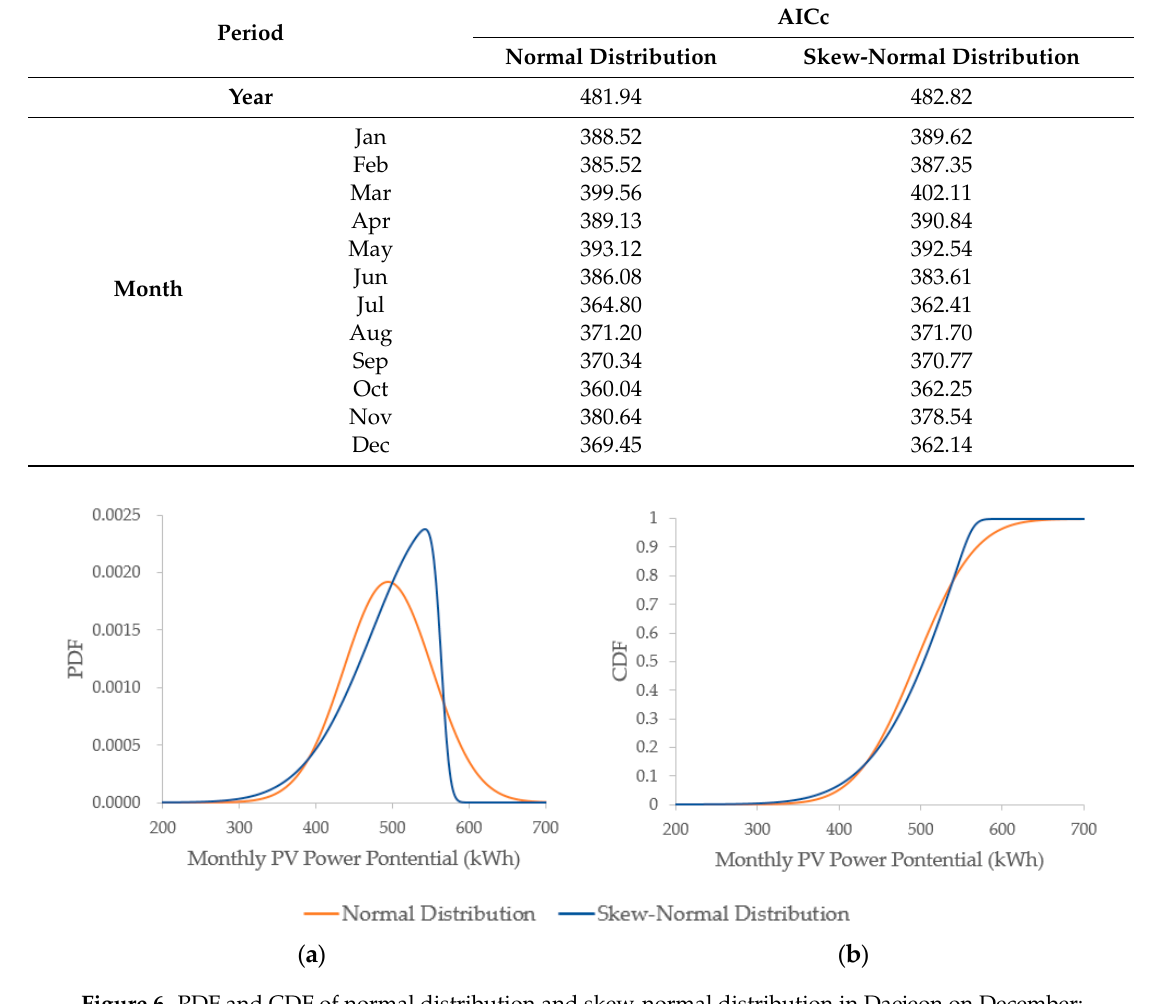
Figure 6. PDF and CDF of normal distribution and skew-normal distribution in Daejeon on December: ( a ) PDF; ( b ) CDF .